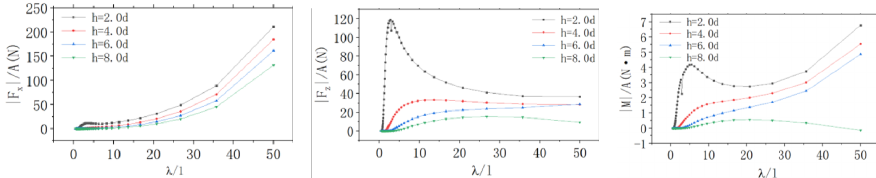
Figure 18. From left to right: second-order wave forces of the Shark-AUV in longitudinal, vertical, and pitch directions at different submerged depths and different wavelengths.